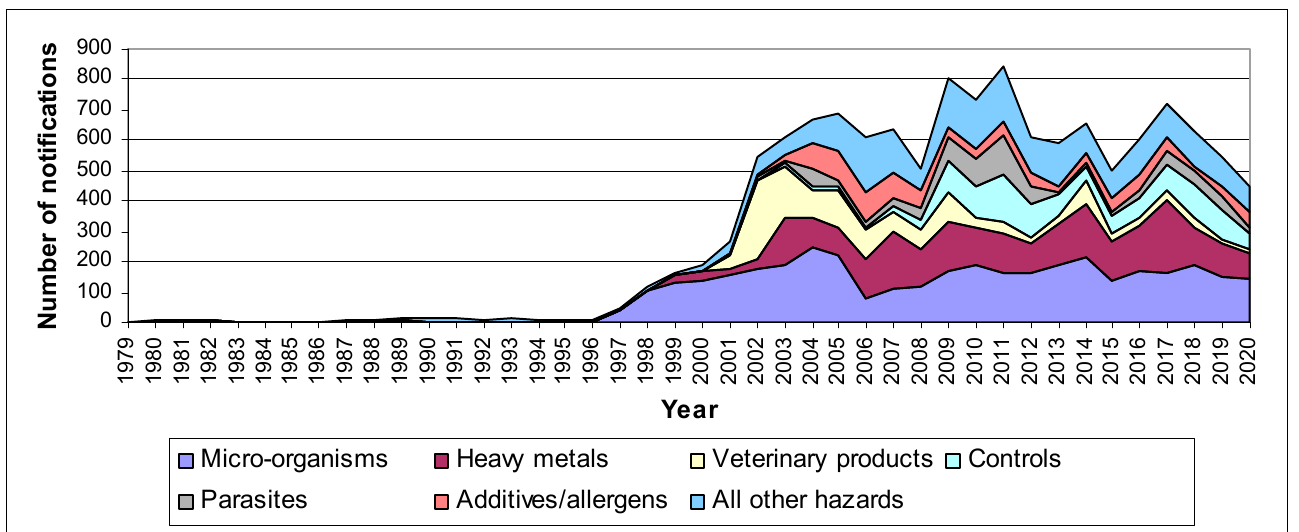
Figure 1. Number of notifications by groups of products concerning seafood reported in the RASFF in 1979–2020.